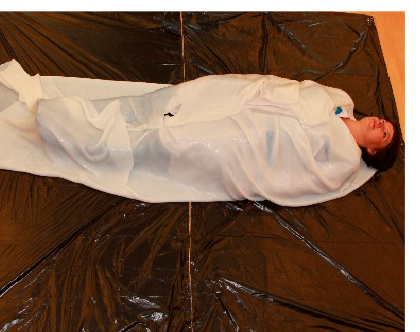
Figure 3. An adult wrapped in the BNC sheet (the ruler is 2 m long).